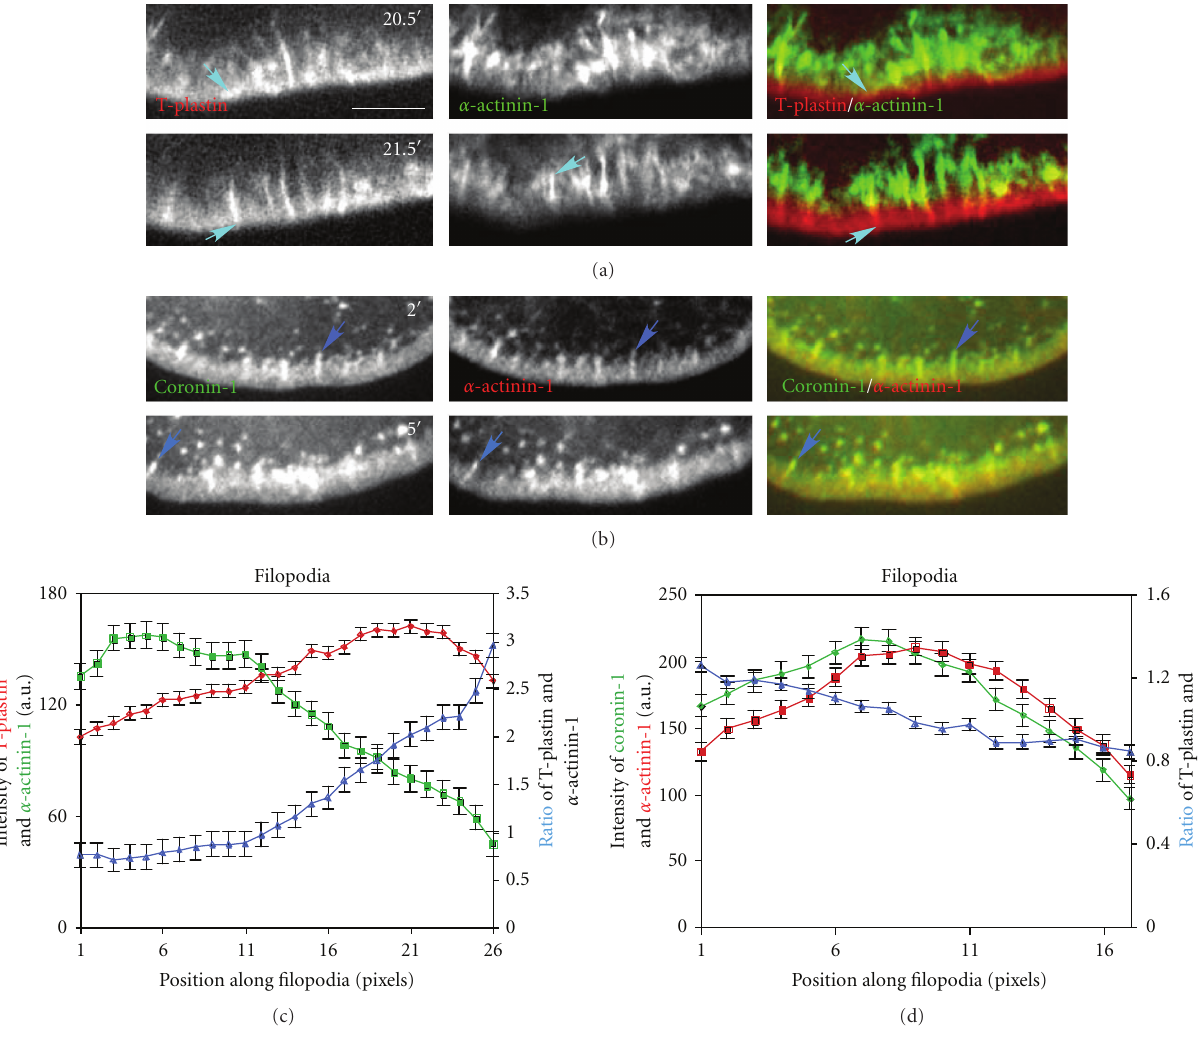
Figure 5: Di ff erential localization of actin cross-linking proteins to lateral filopodia. (a) Live cell time-lapse of B16F1 mouse melanoma cell co-transfected with mCherry-T-plastin and α -actinin 1-GFP, showing just the leading edge. Turquoise arrows indicate the elongation of a stationary filopodia. The entire movie can be found in Supplementary Data, Movie 3. (b) Live cell time-lapse of α -actinin 1-mCherry and coronin 1-GFP, showing large magnification of leading edge. Light blue arrows are showing elongated filopodia. (c) Average fluorescence intensity of three mCherry-T-plastin and α -actinin 1-GFP stationary filopodia, left to right plotting represents proximal to distal of filopodia. (d) Fluorescence intensity of α -actinin 1-mCherry and coronin 1-GFP of stationary filopodia, left to right plotting represents proximal to distal of filopodia. Di ff erent actin cross-linking proteins preferentially localized to di ff erent part of stationary filopodia, T-plastin was stronger at the very distal part, α -actinin 1 stronger in the middle part, and coronin 1 stronger at the very proximal part. Scale Bar 10 μ